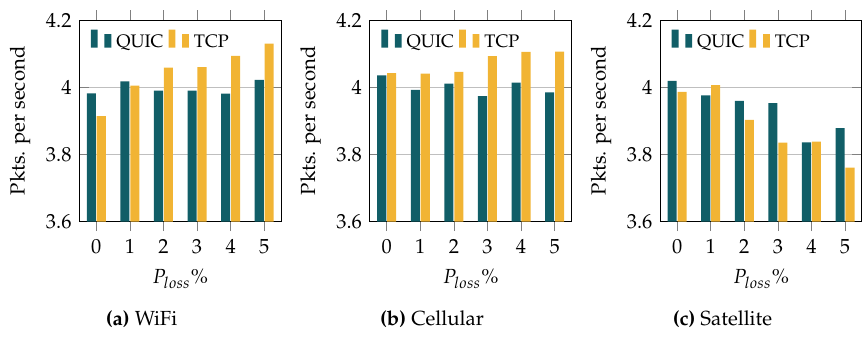
Figure 11. Sending packet per second of MQTT over QUIC and TCP.